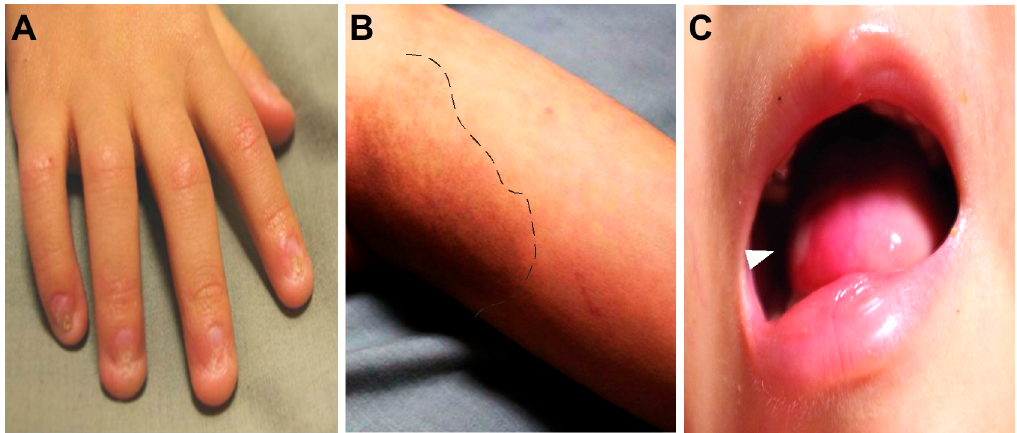
Figure 3. Pre-transplant photographs of the patient showing nail dysplasia ( A ), abnormal skin pigmentation ( B ), and tongue leukoplakia (white arrowhead) ( C ).